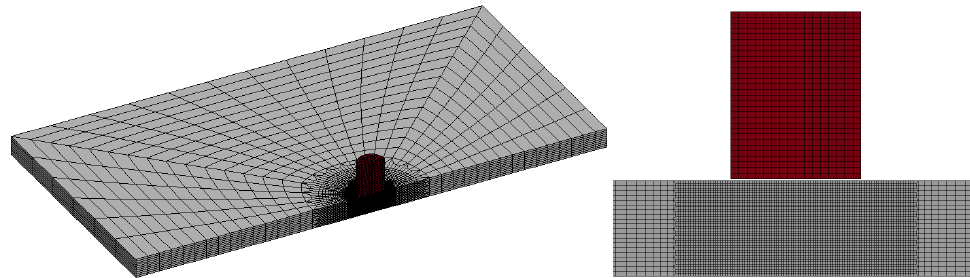
Figure 21. Finite element model used in the numerical simulations.